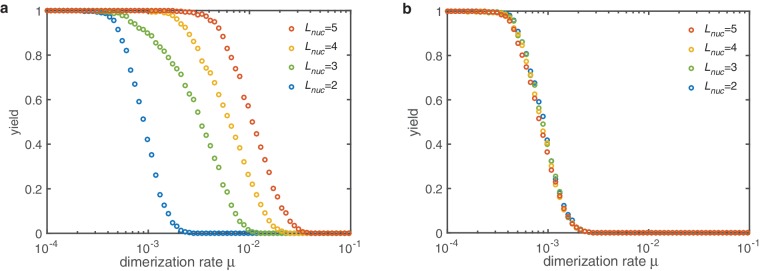
Yield for the dimerization mechanism (α→∞) with different nucleation sizes (colors).(a) If all sub-nucleation growth rates are identical (μi=μ) increasing the nucleation size increases the threshold value μt⁢h. The slow down of nucleation due to the individual sub-nucleation steps in total determines the yield. (b) If the sub-nucleation growth rates increase linearly (μi=μ+(ν-μ)⁢i-1Ln⁢u⁢c-1) no dependence on the nucleation size is observed. The dimerization rate μ1=μ (which is the most limiting step) dominates entirely. Other parameters: L= 60, N= 10000, δ= 1.